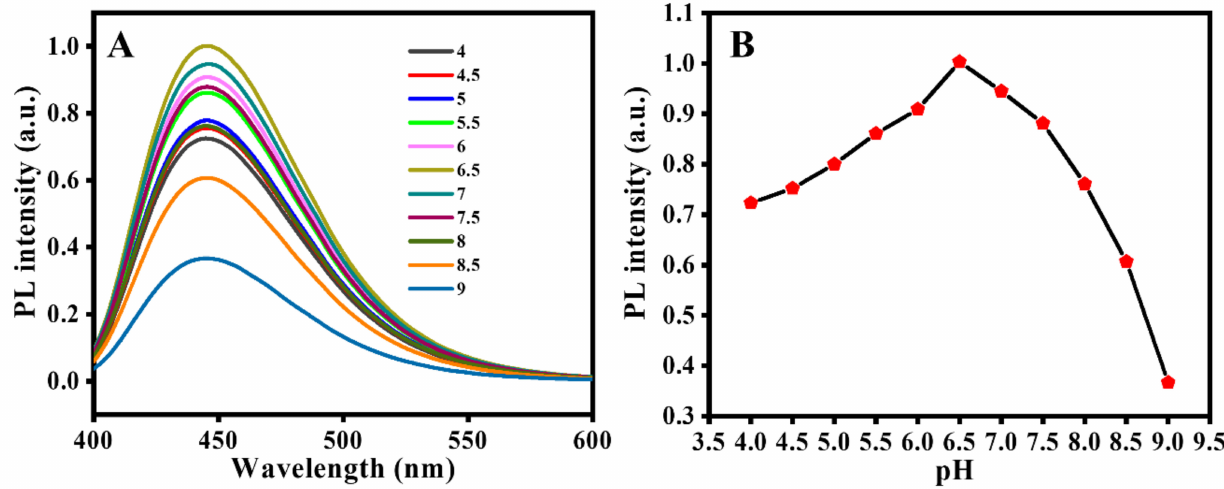
Figure 6. ( A ) Fluorescent spectra and ( B ) fluorescent intensity of the NPCD-MnO 2 nanocoral com- posite in the range of pH from 4 to